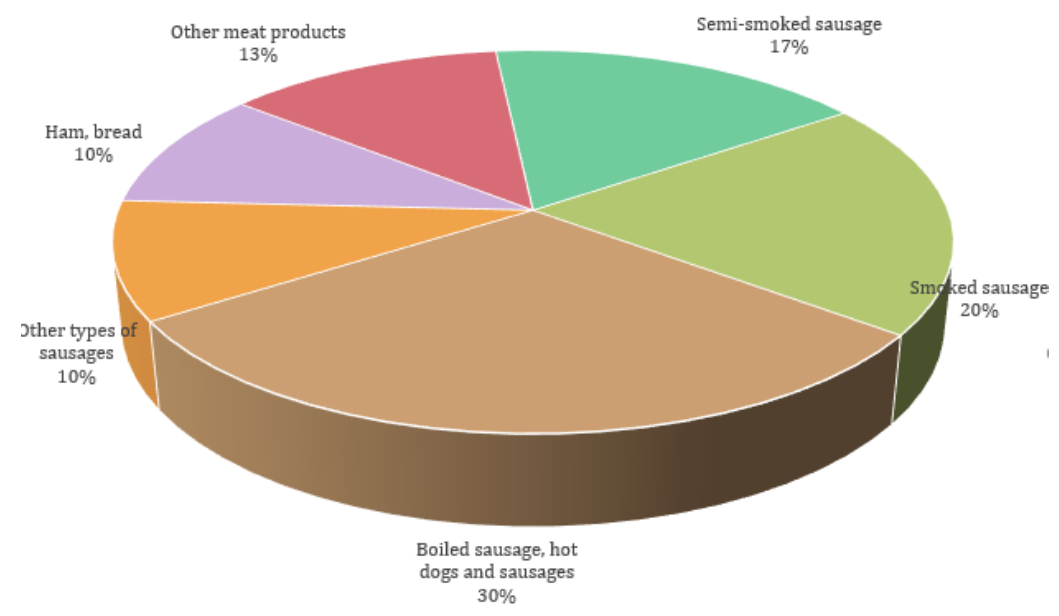
Fig. 1. Assortment of meat products sold by grocery stores in